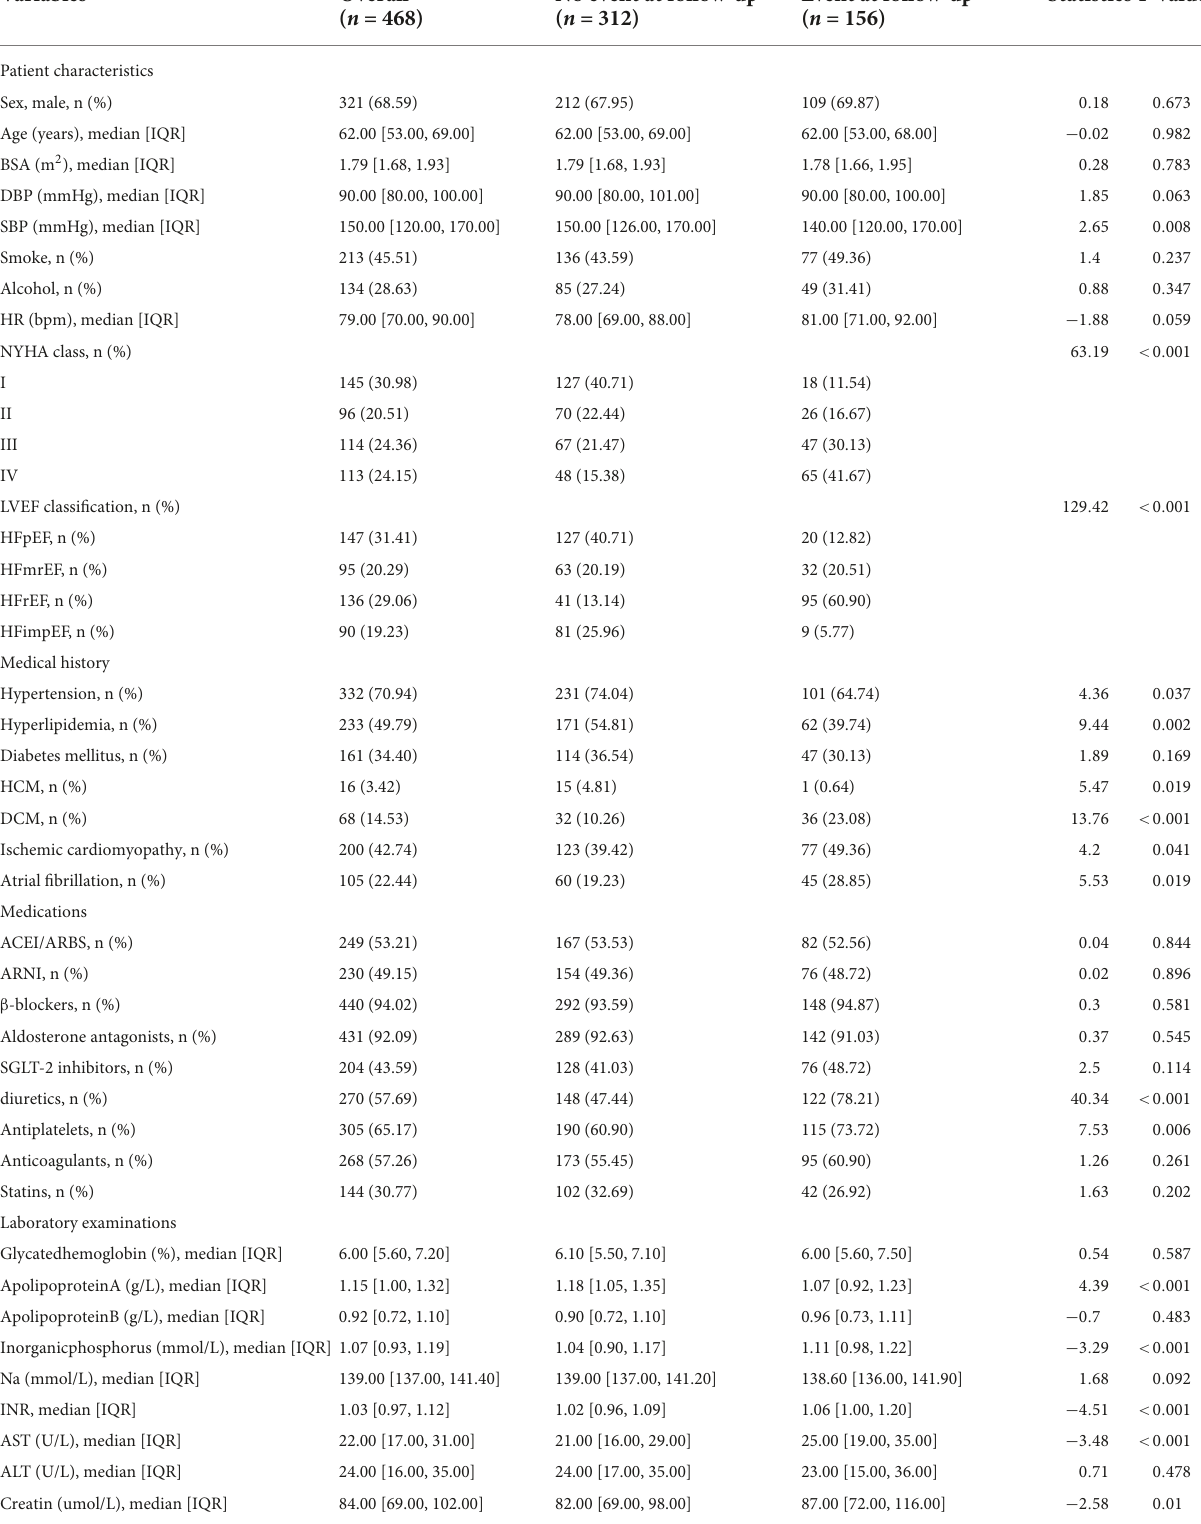
TABLE 1 Baseline characteristics for heart failure (HF) patients during follow-up divided by major cardiovascular events (MACE). Variables Overall